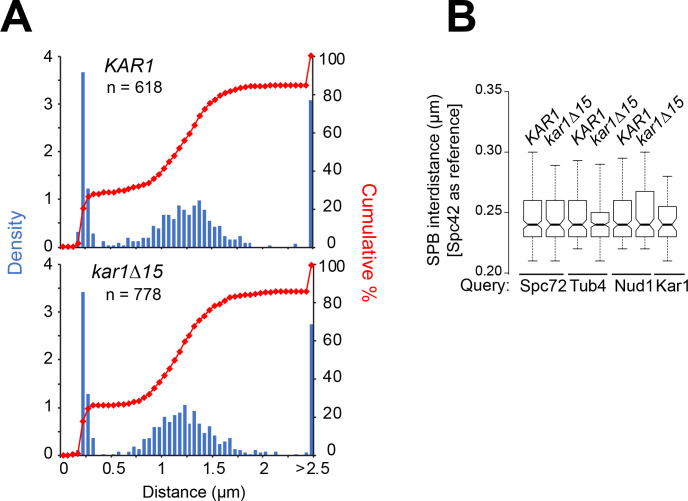
SPB inter-distance as basis for classification of SPBs by cell cycle stage.(A) Distribution of SPB inter-distances using Spc42-mT2 as reference in asynchronous KAR1 or kar1∆15 cell populations analyzed by 3D-SIM. These values were used to classify SPBs into unseparated SPBs (<350 nm), SPBs in short spindles (<2.5 µm) and SPBs in elongated spindles (>2.5 µm). (B) Boxplot for distribution of SPB inter-distances in all unseparated SPBs selected for analysis from asynchronous cell populations in Figures 2 and 3 and Figure 2—figure supplement 2. In all cases, analysis was performed after Spc42-mT2 labels (reference channel) were subject to 3D-Gaussian fit and realignment, as described in the Materials and methods.